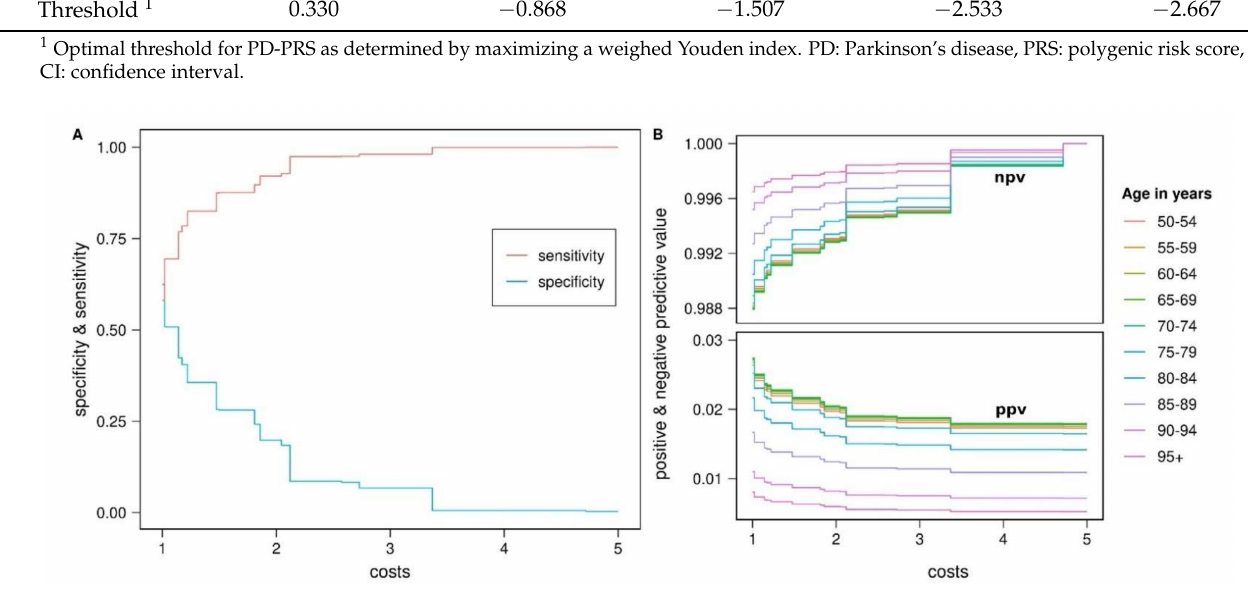
Figure 5. Prognostic value of PD-PRS. ( A ) Sensitivity and specificity of PD-PRS for the optimal threshold were determined by maximizing a weighted Youden index. The relative costs of false negative vs false positive results varied from 1 to 5. ( B ) ppv and npv were calculated from the costs-based sensitivity and specificity and the residual lifetime incidence (see Methods and Table A3) in 10 age groups. PRS: polygenic risk score, PD: Parkinson’s disease, ppv: positive predictive value, npv: negative predictive value. Table 4. Costs- and age-dependent PD-PRS predictive